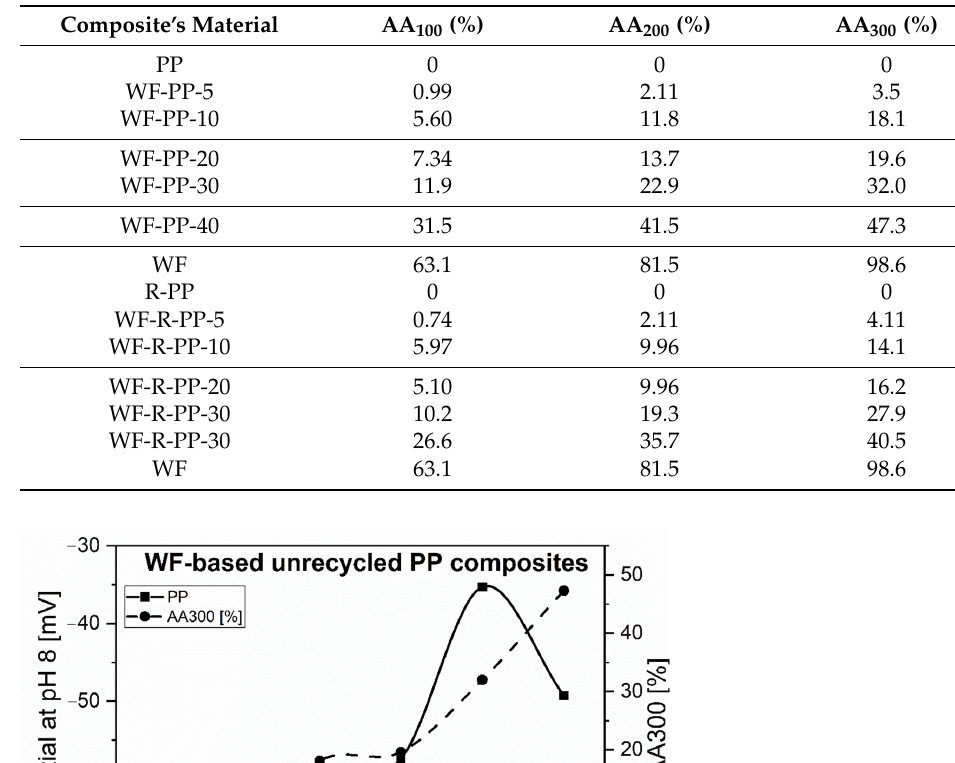
Table 3. Antioxidant activities of WF-PP and WF-R-PP composites represented by the percental decrease of absorbance of DPPH at 515 nm after 100, 200 and 300 s.